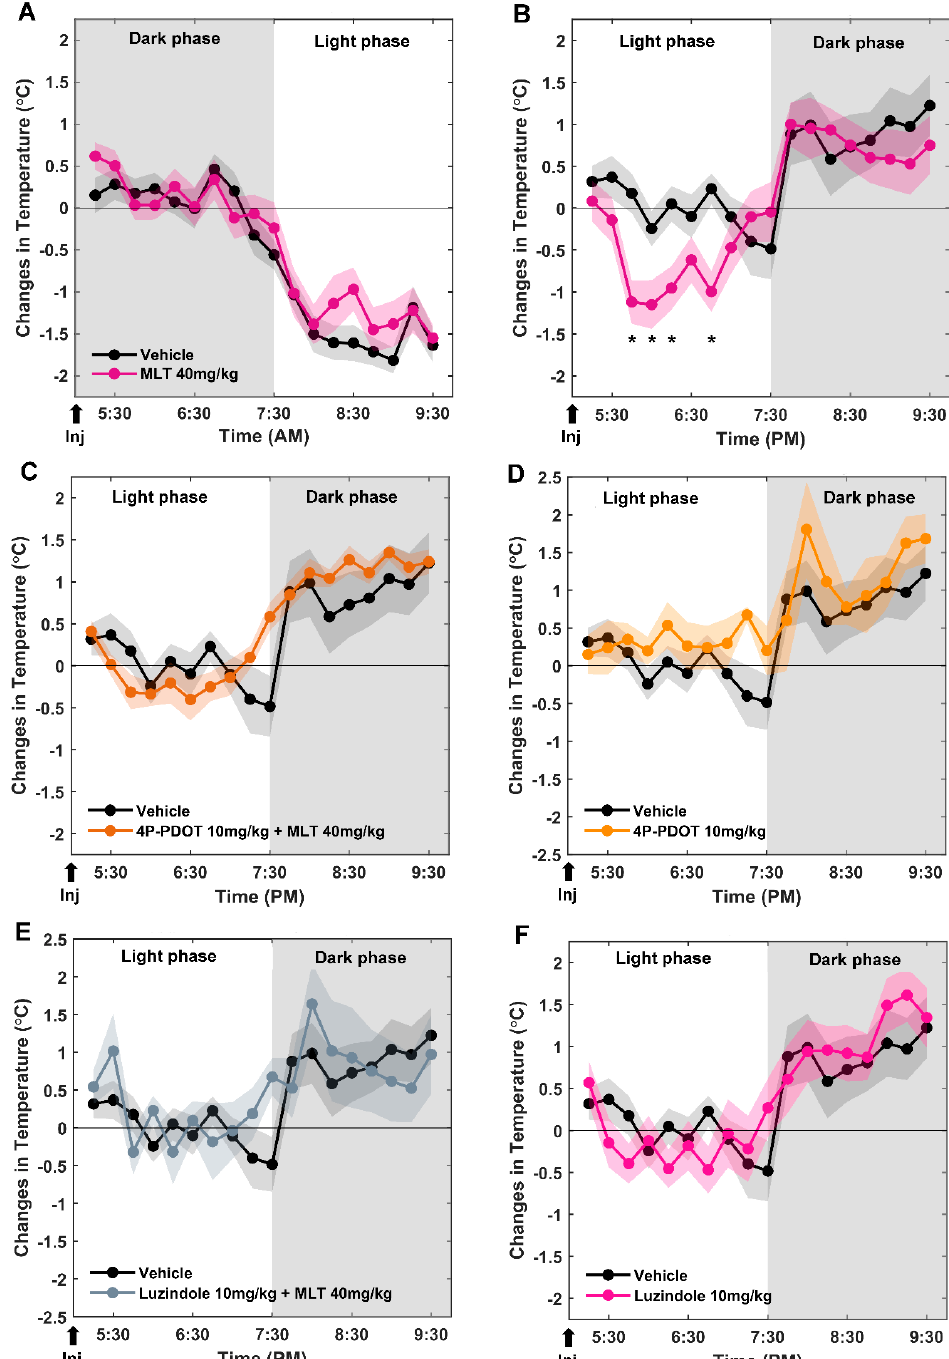
Figure 2. Changes in T b after MLT administration (40 mg / kg) during the light and the dark phase. ( A ) MLT does not produce changes in T b when administrated at 5:00 a.m. ( B ) MLT administrated during the dark phase (5:00 p.m.) decreases the T b immediately after the administration compared with vehicle treated rats. ( C ) 4P-PDOT (10 mg / kg) pre-treatment blocks the e ff ect of MLT on T b during the light phase. ( D ) 4P-PDOT (10 mg / kg) injected during the light phase does not a ff ect T b . ( E ) Pre-treatment with luzindole (10 mg / kg) blocks the e ff ect of MLT on T b during the light phase. ( F ) luzindole (10 mg / kg) injected during the light phase does not a ff ect T b . Data are expressed as mean ± SEM (graded shades). Lights on at 7:30 a.m. and o ff at 7:30 p.m. * p < 0.05 vs. vehicle; two-way ANOVA for repeated measures followed by Bonferroni post hoc test. Inj: s.c. injection of either vehicle, MLT, MLT + 4P-PDOT, 4P-PDOT, MLT + luzindole, or